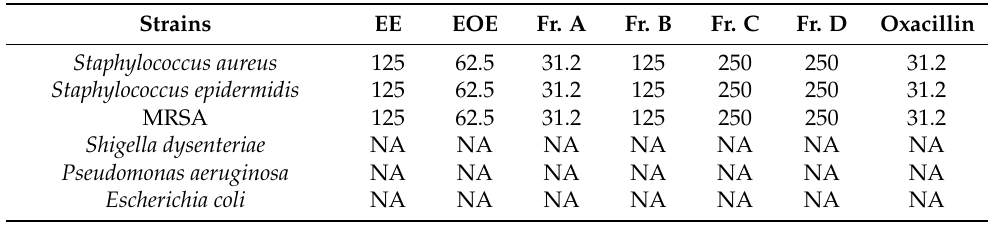
Table 2. The MICs ( µ g/mL) of different fractions from